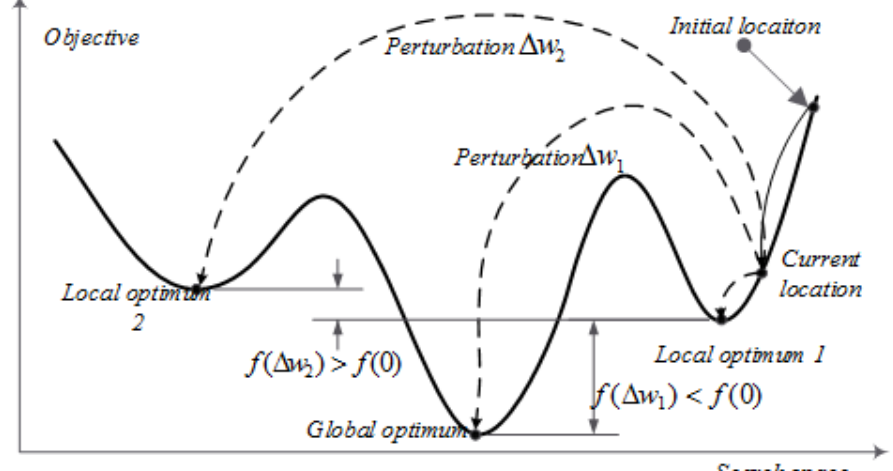
Figure 2. Principle of random perturbation with different perturbation intensity. Suppose the next location without perturbation is a point near local optimum 1. The next location with perturbation intensity ∆ w 1 is a point near the global optimum. The next location with perturbation intensity ∆ w 2 is a point near local optimum 2. The objective is to minimize the objective function f ( · )